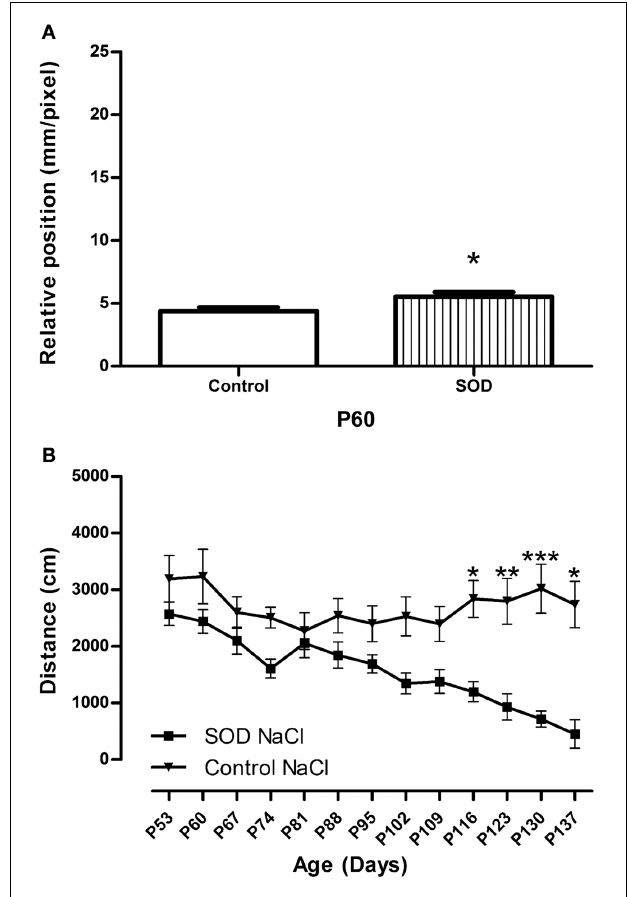
FIGURE 1 | Dose effect of Gacyclidine on hSOD1 G93A mice survival and weight. (A) —Kaplan-Meier curves of hSOD1 G93A mice injected i.p with NaCl ( n = 21), GK11 0.1mg/kg ( n = 15) or GK11 1mg/kg ( n = 5). (B) —Weight changes (g) in control (dash line) and transgenic mice (continuous line) injected with NaCl, GK11 0.1mg/kg or GK11.1mg/kg. Two-ways ANOVA followed by Tukey-Kramer test [ F ( 10 , 695 ) = 96 . 18 ]. Weight of NaCl treated controls and transgenics significantly differs from P109 whereas weight of GK11 (both doses) treated controls and transgenics significantly differ from P123. ∗ p < 0 . 05 and ∗∗∗ p < 0 . 001.